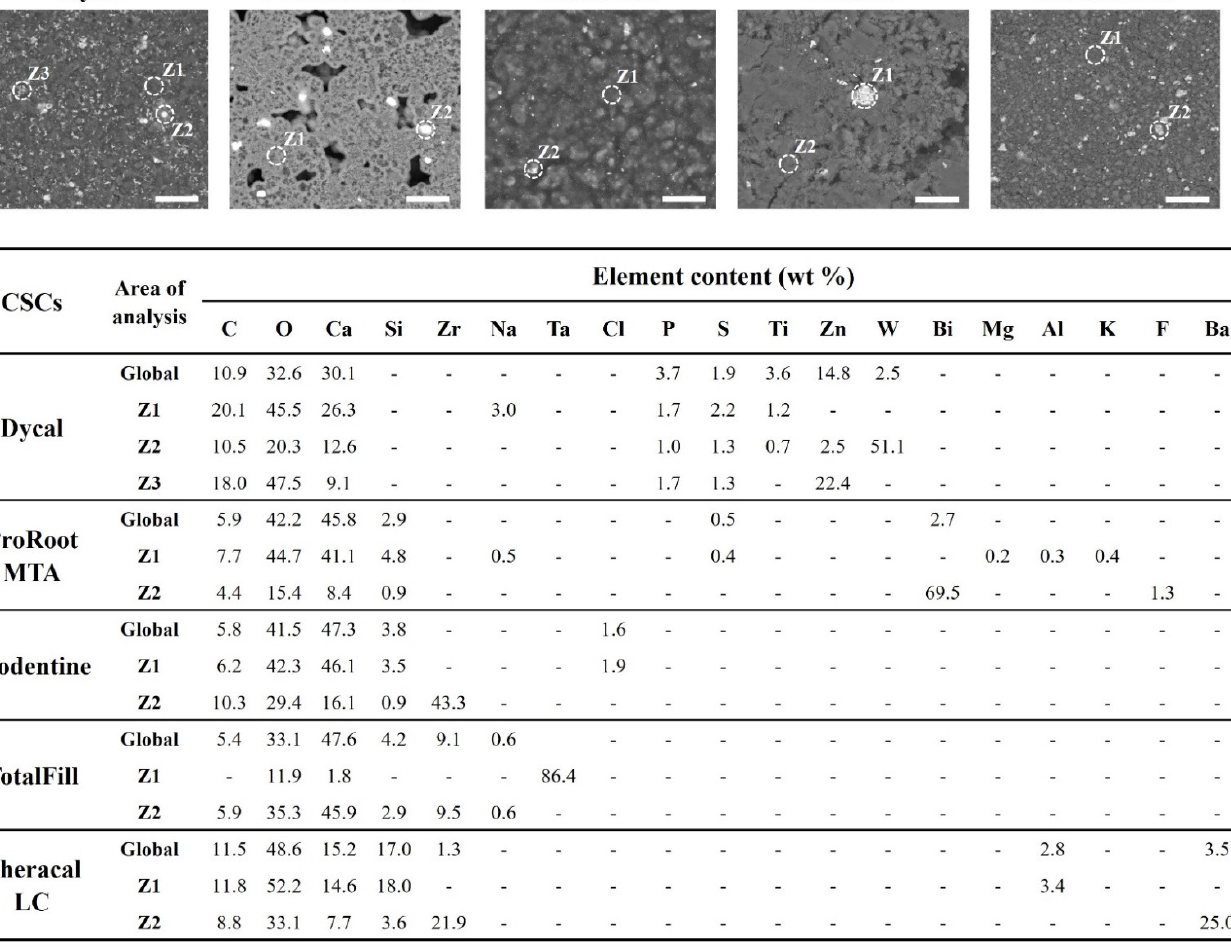
Figure 1. Back-scattered scanning electron micrographs of the calcium silicate-based cements (CSCs) showing microstructural components (scale bar 10 µm) and respective elemental composition evaluated by EDS, for the view area and for the pointed zones in the images.